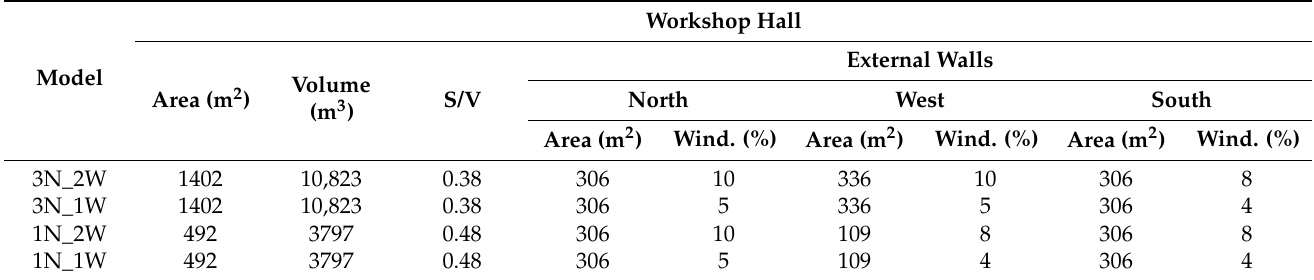
Table 1. Main characteristics of the different configurations evaluated.